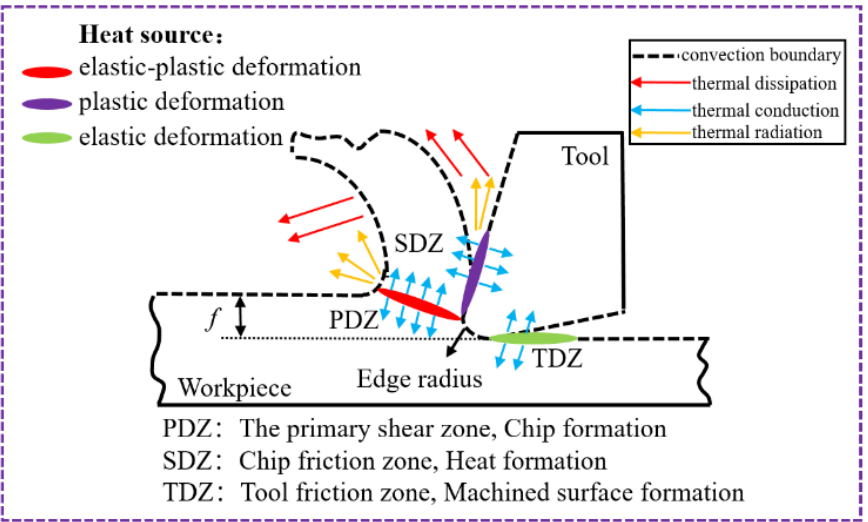
Figure 6. Mechanism and heat generation of machined surface integrity under tool wear condi- tions.